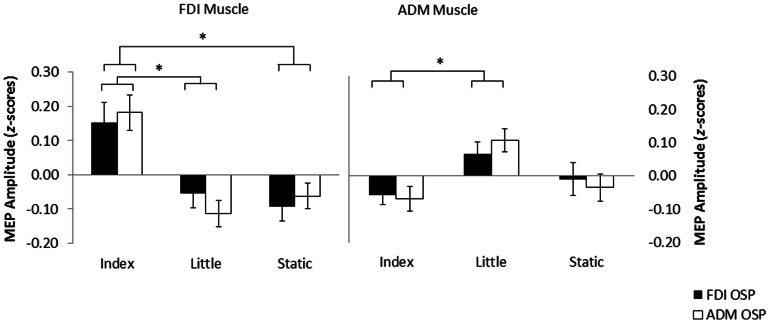
The mean MEP amplitudes recorded from the participants' right FDI (left panel) and right ADM (right panel) muscles during observation of index, little, and static videos recorded from the FDI-OSP (white) and ADM-OSP (black) in experiment 2.The MEP amplitudes are presented as z-scores (mean ± SE). Significant differences are indicated by asterisks (*p = 0.05).